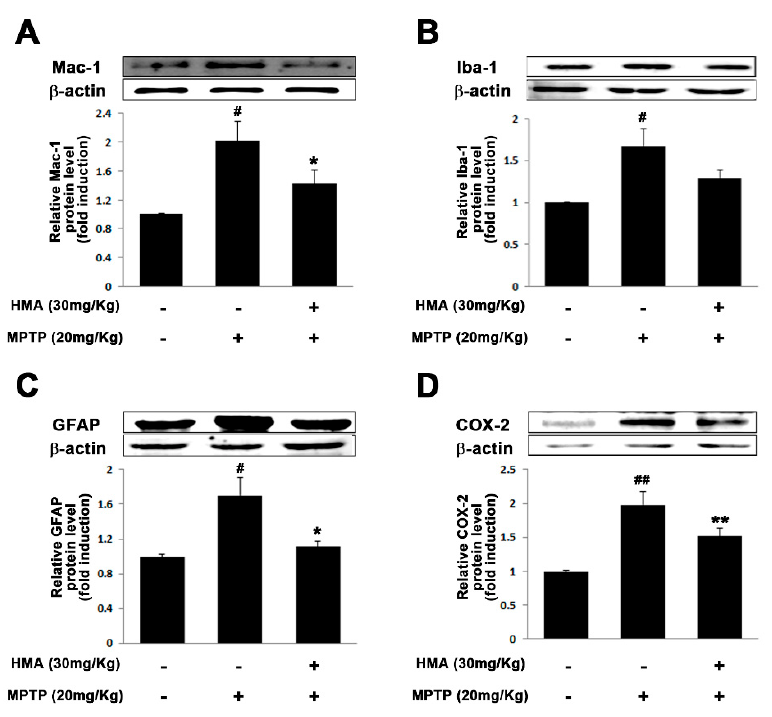
Figure 7. E ff ect of HMA on MAC-1, Iba-1, GFAP, and COX-2 expressions in MPTP-intoxicated mice. MAC-1 ( A ), Iba-1 ( B ), GFAP ( C ) and COX-2 ( D ) protein levels in the SNpc were assessed by Western blot analysis. Corresponding relative expression (fold change) levels are shown, respectively. β -Actin was used as an internal control. Data are mean ± S.E.M. ( n = 3) performed in three independent experiments. # p < 0.05 and ## p < 0.01 as compared with the control group; * p < 0.05 and ** p < 0.01 as compared with the MPTP-intoxicated group by one-way ANOVA. ( A ) F(2,6) = 6.609, p = 0.304; ( B ) F(2,6) = 5.835, p = 0.391; ( C ) F(2,6) = 6.788, p = 0.0288; ( D ) F(2,6) = 24.33, p =